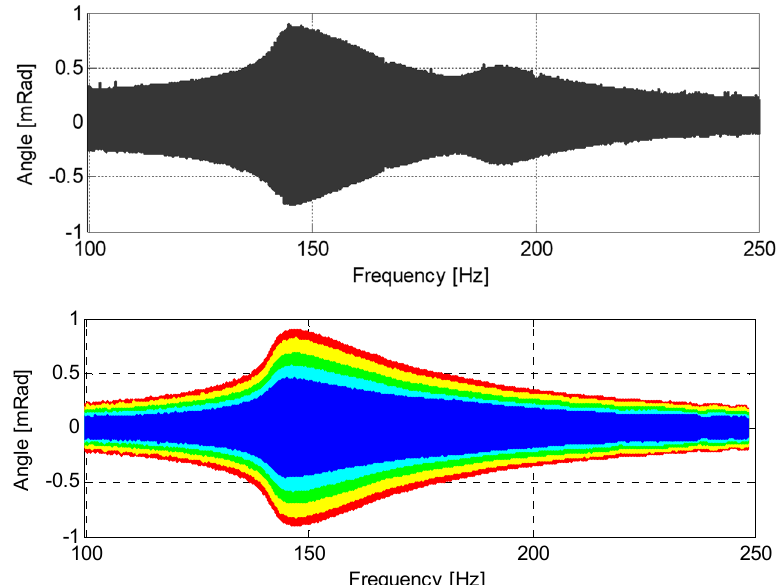
Figure 24. The results of RC testing. Standard RC test results are at the top; the results from the additional accelerometers are at the bottom. Material: saclSi 1; Isotropic pressure 100 kPa; Frequency spectrum 100–250 Hz; Excitation (torque) amplitude 4 V (– original built-in sensor, – the top sensor, S1, – the second sensor from the top, S2, – the third sensor from the top, S3, – the fourth sensor from the top, S4, – the bottom sensor, S5).